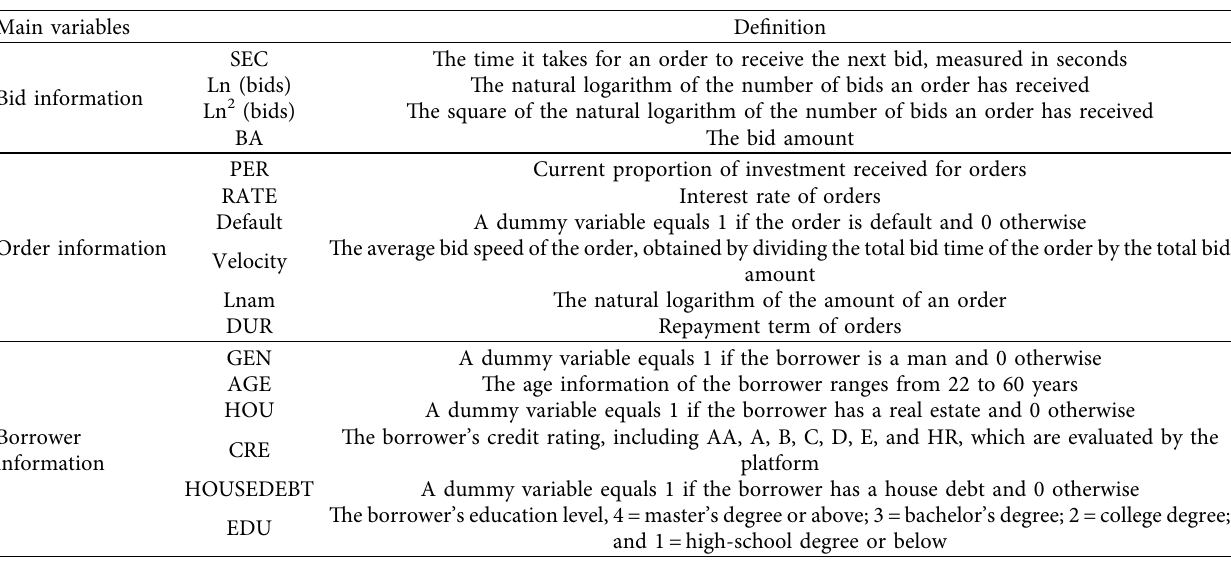
Table 1: Variable definition.